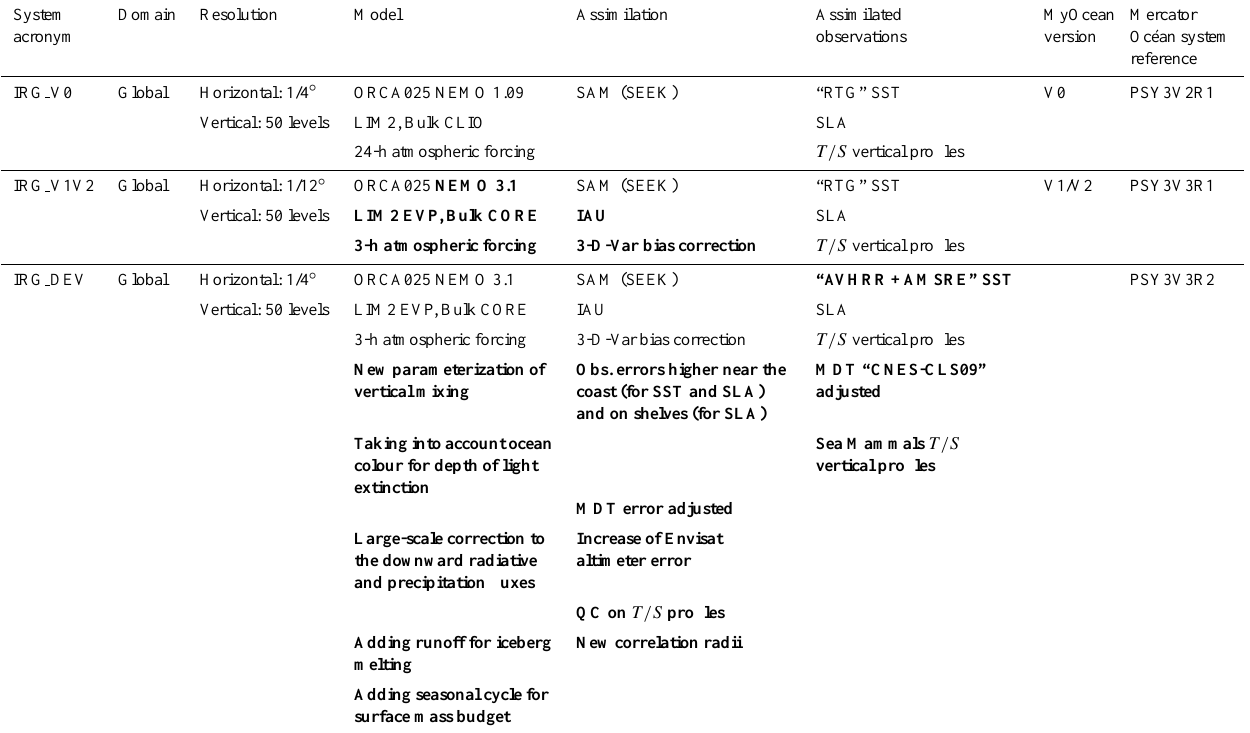
Table 1. Specifics of the Mercator Oc´ean IRG systems. In bold, the major upgrades with respect to the previous version.